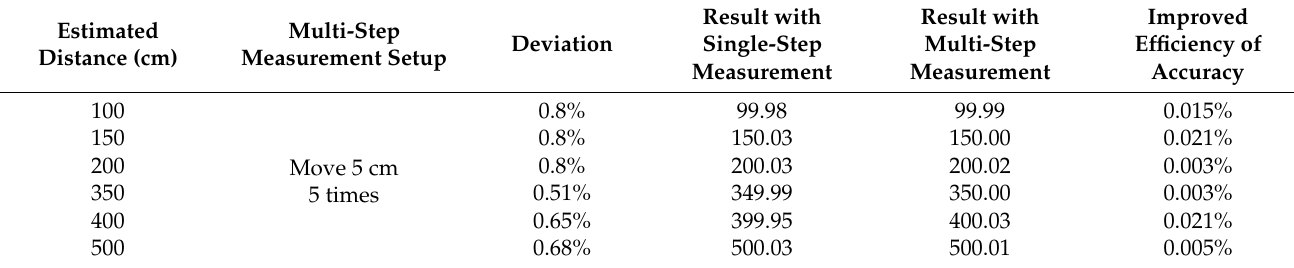
Table 4. Simulation results of multi-step measurement for deviation values of 0.51% to